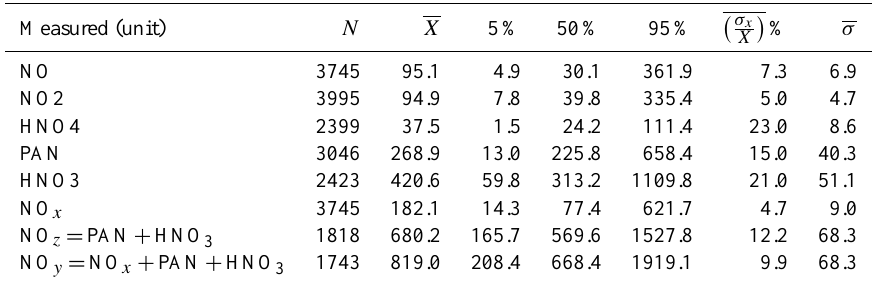
Table 1. Measurement descriptive statistics (mean: X ; percentiles: 5, 50, 90%), average relative uncertainty as a percent (cid:0) σ x uncertainty in measurement